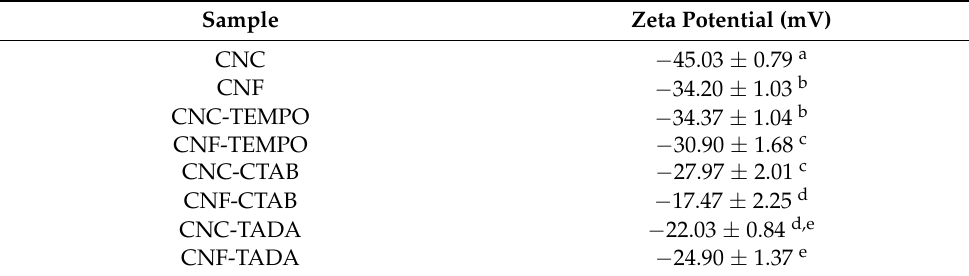
Table 1. Zeta potential results of modified and unmodified CNC and